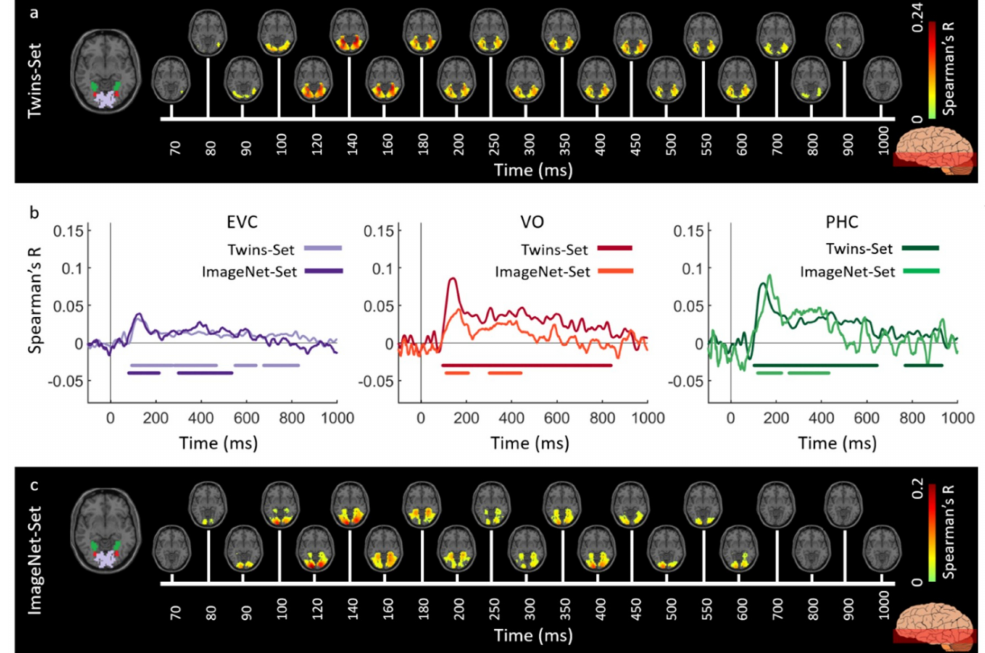
Figure 6. Spatiotemporal neural dynamics of vision in ventral stream: ( a ) An axial slice encompassing early visual cortex (EVC) and ventral ROIs, occipital (VO) area and parahippocampal cortex (PHC). The significant correlation maps for Twins-set (Experiment 1) in this axial slice depicted over time (n = 15, cluster-definition threshold P < 0.001, cluster threshold P < 0.01); ( b ) The correlation time series are computed based on spatially restricted searchlight voxel-wise fusion analysis (see Methods). The depicted curves from left to right compare these time series in EVC and ventral ROIs VO and PHC for Twins-set (Experiment 1) and ImageNet-set (Experiment 2). Significant time points depicted with color coded lines below the graphs are determined with sign-permutation tests (n = 15; P < 0.01 cluster-definition threshold, P < 0.01 cluster threshold); ( c ) The significant correlation maps for ImageNet-set (Experiment 2) in the same axial slice as (a) depicted over time (n = 15, cluster-definition threshold P < 0.001, cluster threshold P <